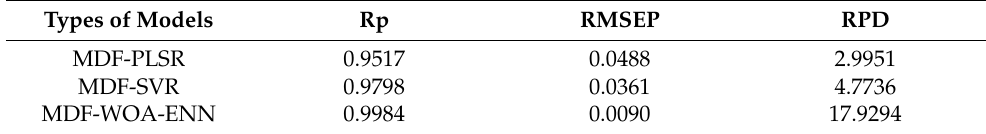
Table 3. Model performance indicators based on middle-level data fusion and single